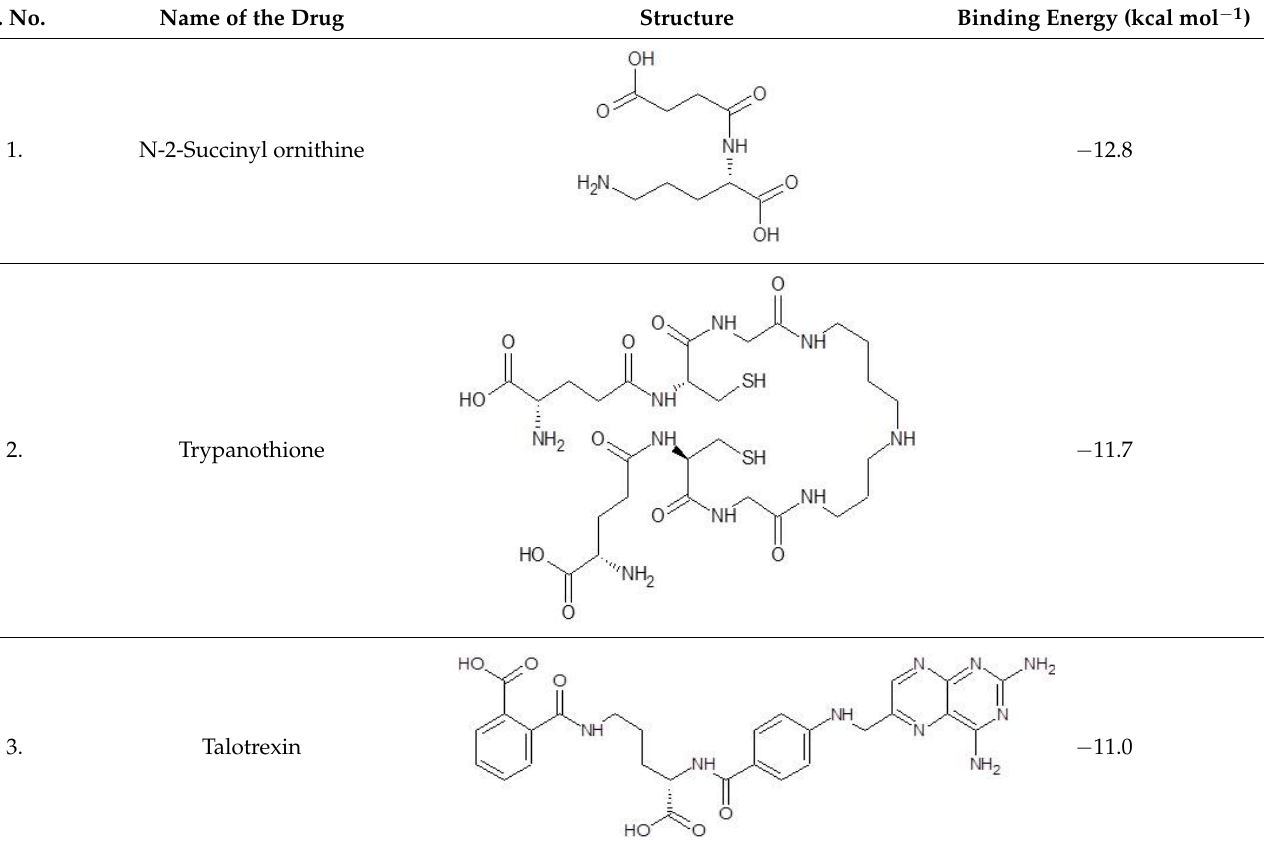
Table 2. Structures and binding energies of drugs that have substructures of L -Ornithine. S. No.